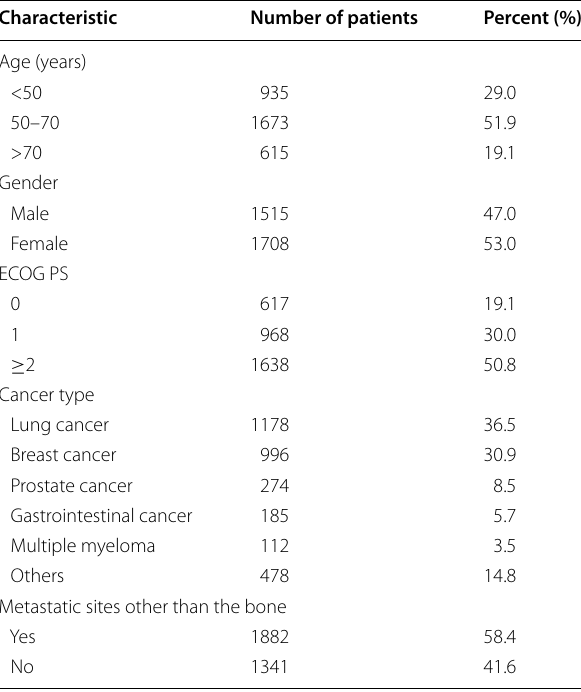
Table 1 Demographic and clinical characteristics of the 3223 patients with bone metastases